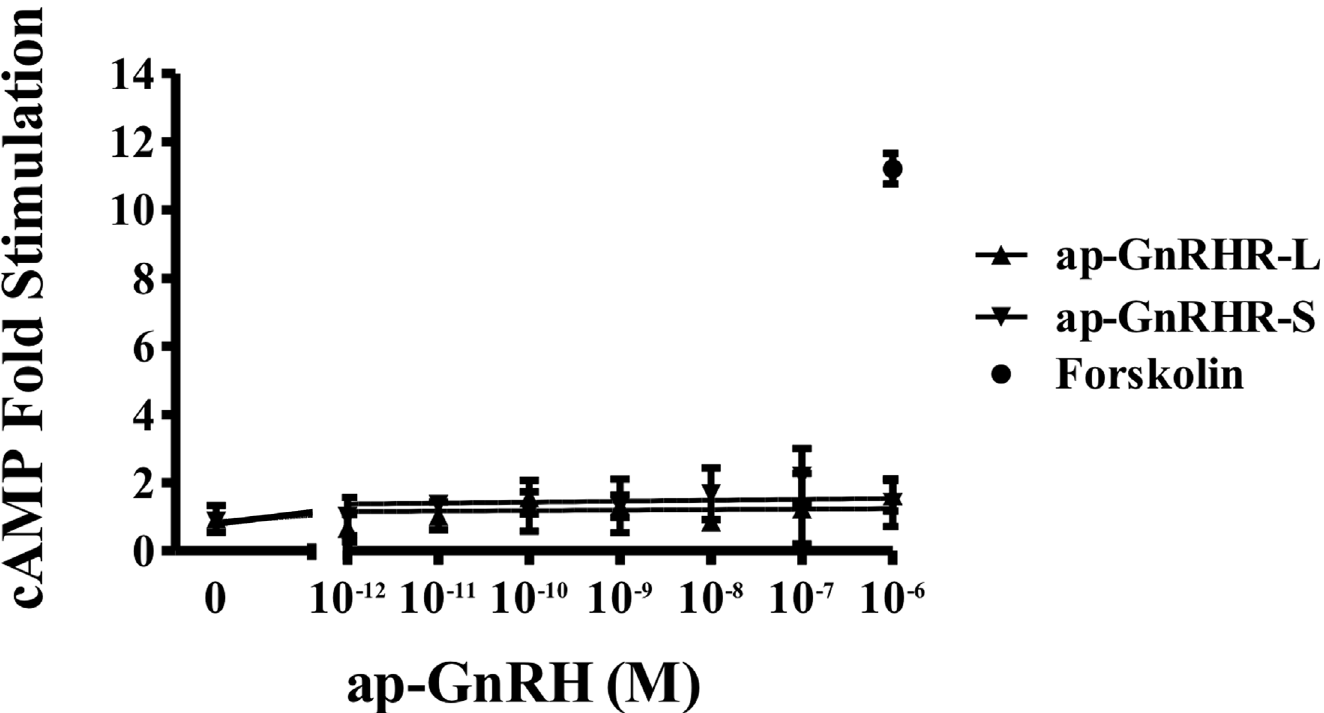
Fig 7. ap-GnRH did not stimulate cAMP accumulation in S2 cells transfected with either ap-GnRHR-L or ap-GnRHR-S. Data are expressed as fold stimulation over cAMP levels in the untreated cells. Forskolin was used as a positive control. N = 3 assays run in triplicates.